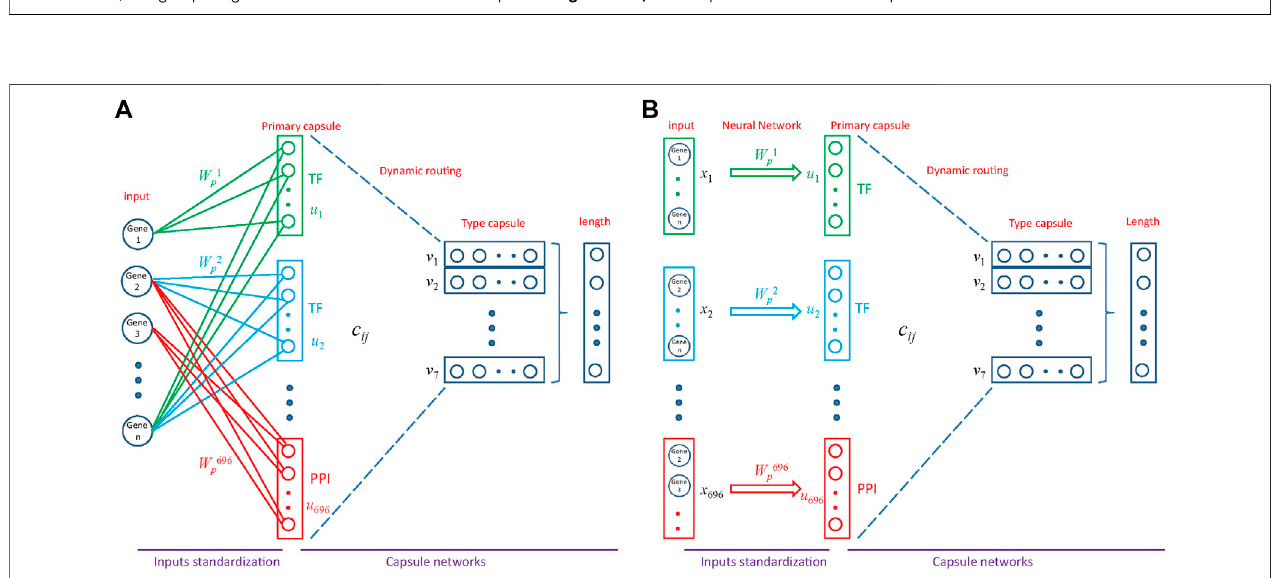
FIGURE 4 | The comparison between MultiCapsNet and feed forward neural network shows the high performance and interpretability of MultiCapsNet. (A) The AUC scores demonstrate that the MultiCapsNet model achieves very high classi fi cation performances in all three classi fi cation categories. (B) The normalized group (data source) importance scores generated by MultiCapsNet and feed forward neural network are highly correlated.